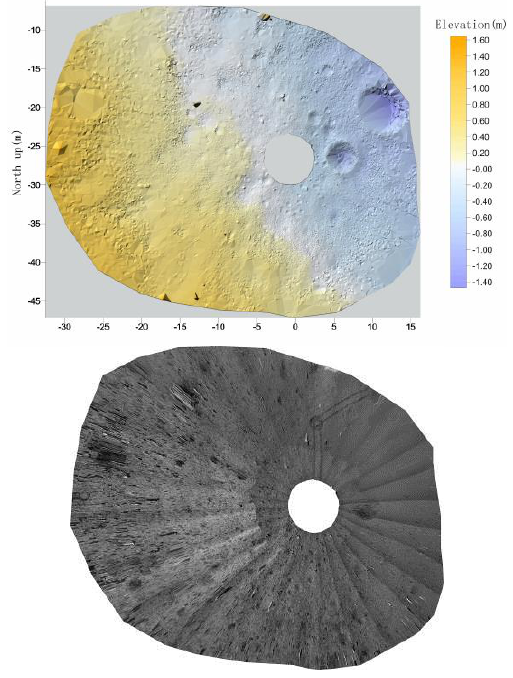
Figure 3. Reconstructed DEM and DOM near points E.